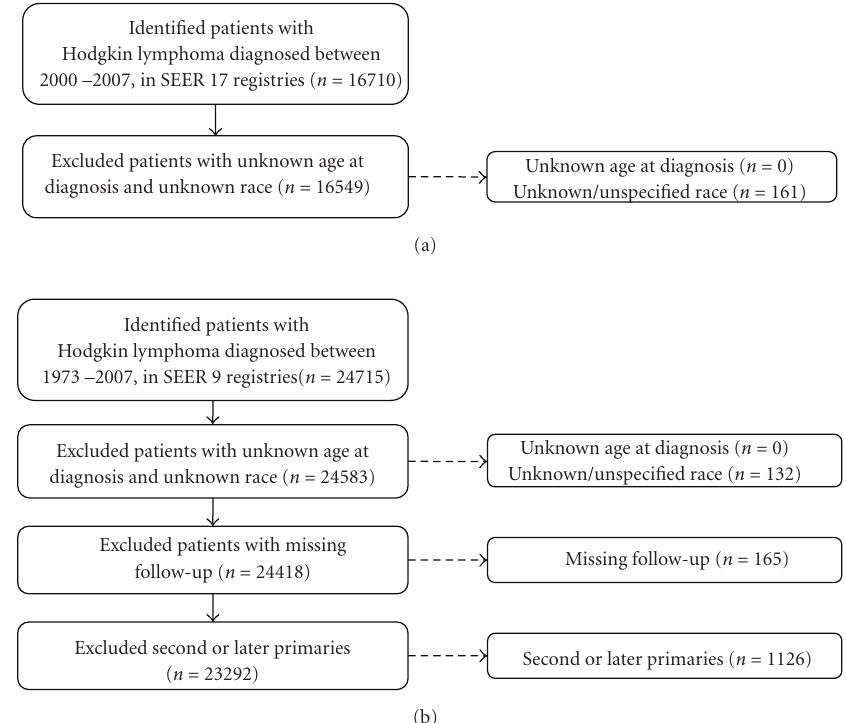
Figure 1: Selection of study cohort. These figures provide an overview of the study cohort with reasons for inclusion/exclusion through the selection process. (a) Selection of the cases included in the incidence analyses. (b) Selection of the cases included in the survival analyses.